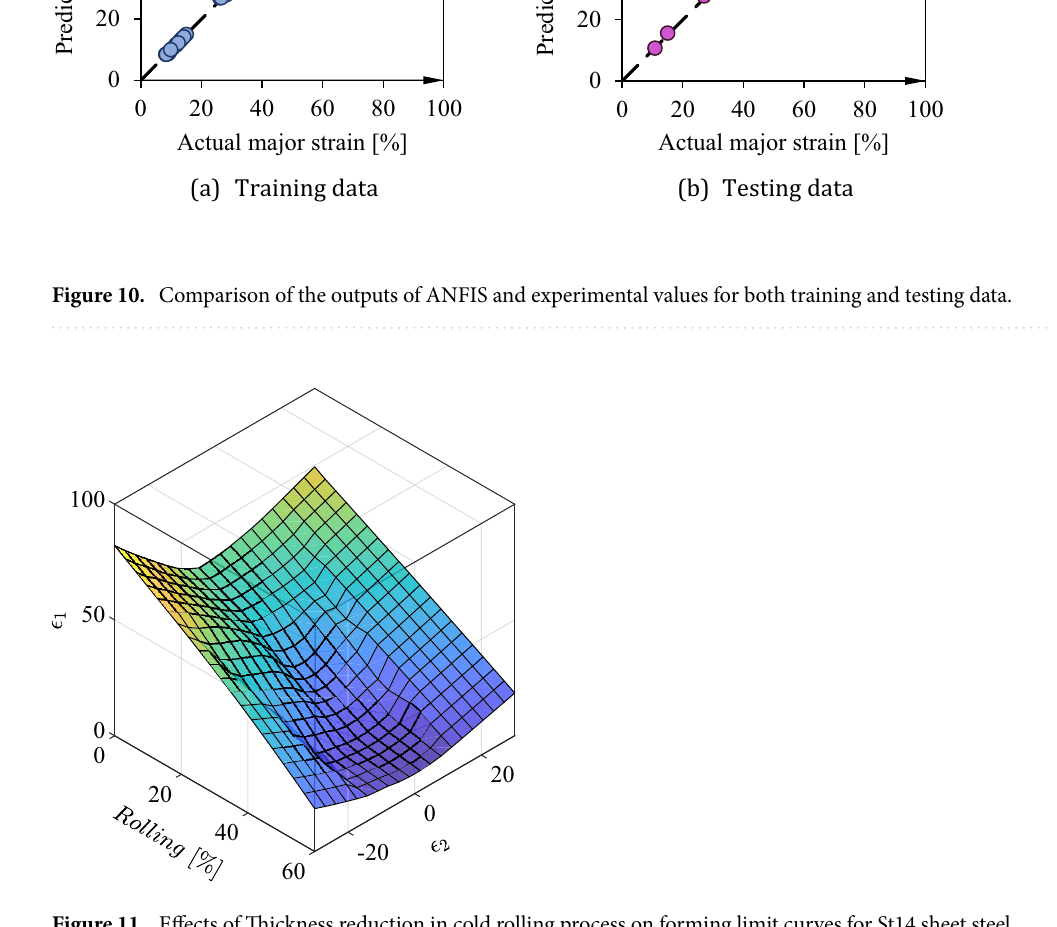
Figure 11. Effects of Thickness reduction in cold rolling process on forming limit curves for St14 sheet